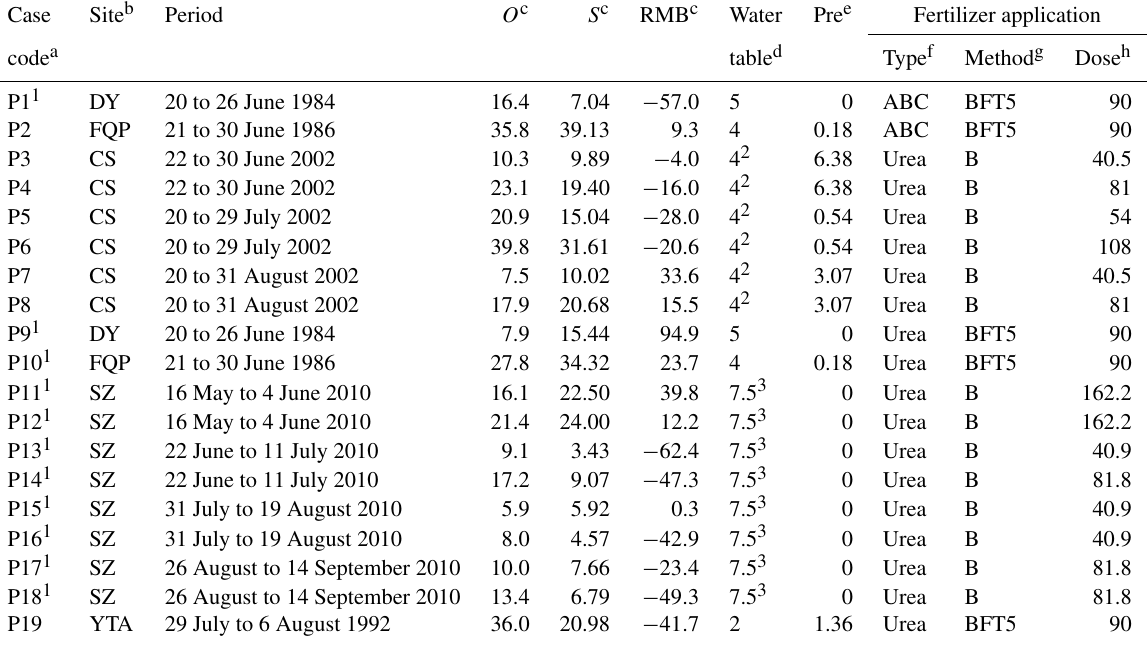
Table 2. Observed and simulated cumulative ammonia volatilization during the measurement periods, model biases, and management prac- tices of individual fertilizer application cases in the rice paddy